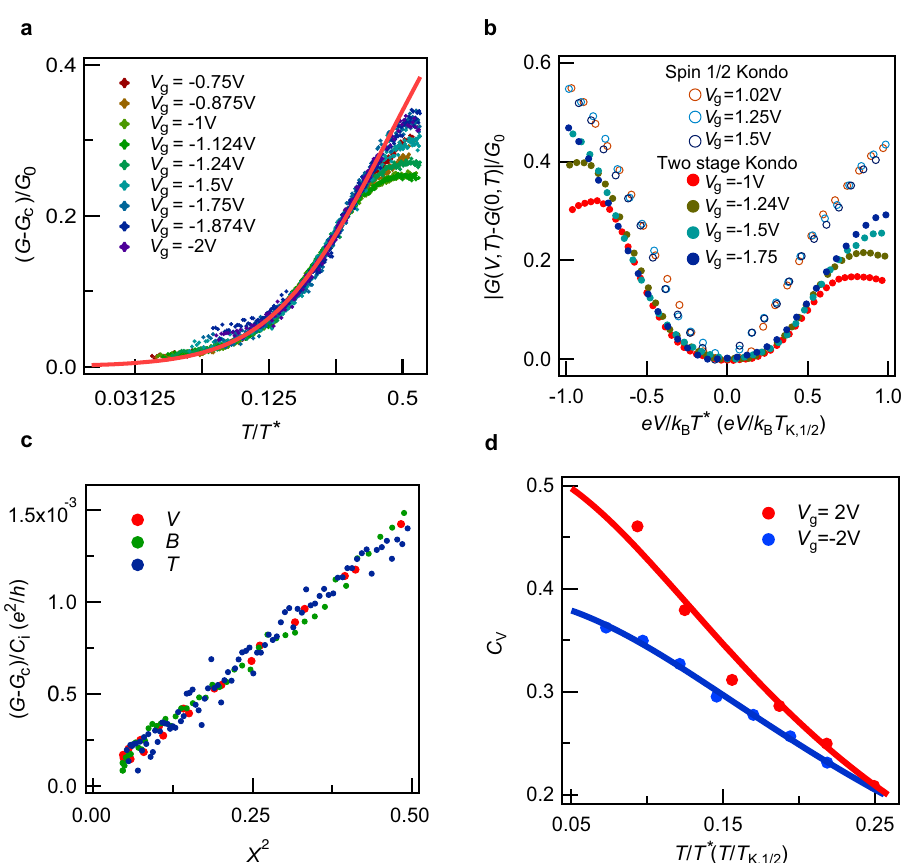
Fig. 4 Universal scaling of two-stage Kondo resonance. a The normalized zero-bias conductance, ( G – G c )/ G 0 for device 1 in region II at various gate voltages, shows a universal function of T / T * . The solid line is the scaling form of invert spin-1/2 Kondo resonance. b The differential conductance vs. V sd curves at different V g are scaled to an identical line by T * or T k,1/2 c Plot of scaled low-energy differential conductance ( G − G c )/ C i ( V g = − 2 V and C i are the (cid:4) (cid:5) (cid:4) (cid:5) (cid:6) (cid:7) 2 2 2 and g μ B B , π T (represented by X 2 ). The linear relation between conductance and X demonstrates a coef fi cients, i = V, T and B) against eV sd T (cid:3) k B T (cid:3) k B T (cid:3) quadratic behavior for T , V , and B . d Values of C v for two-stage Kondo ( V g = − 2 V) and spin-1/2 Kondo effect ( V g = 2 V) at different temperatures. The solid lines are fi tting to Eq.